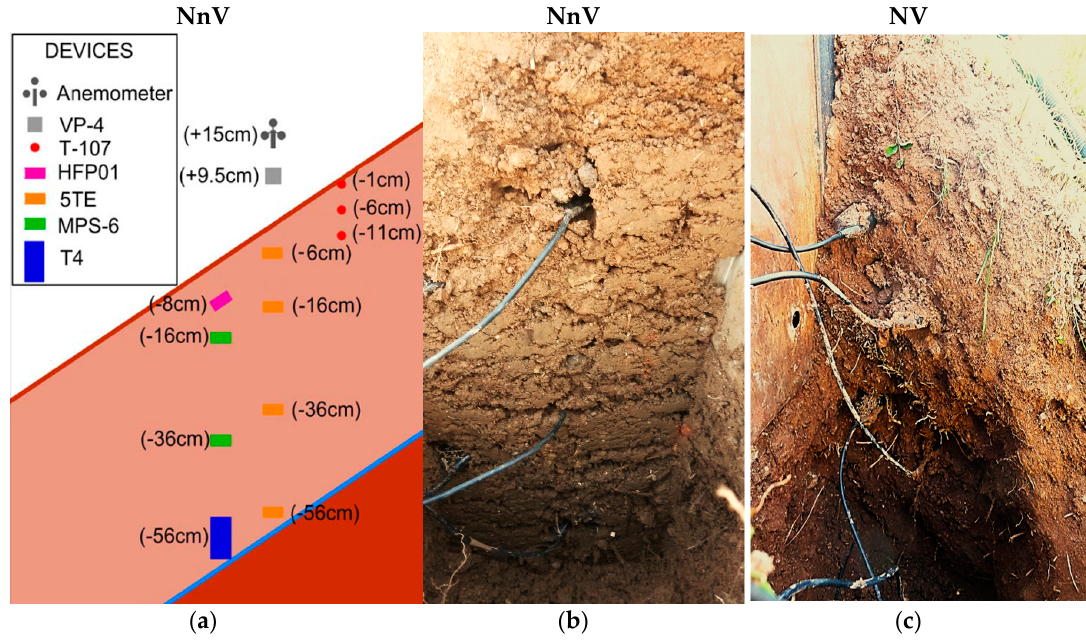
Figure 4. ( a ) Schematic design of the vertical profile of NnV indicating the location of the sensors; ( b ) photograph taken during installation of sensors at the NnV profile; ( c ) photograph taken during installation of sensors at the NV profile. Table 1. Characteristics of the sensors installed in the vertical slope profiles. Table 2. Location of selected sensor in the four vertical profiles. Only devices focusing on temperature, volumetric water content, and pore water pressure are